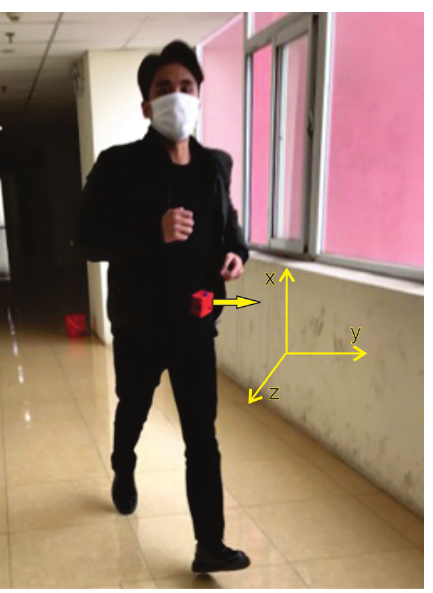
Fig 8. The wearable device (red) was attached to the waist and secured by an elasticated strap. The x-axis of the accelerometer was parallel to the earth’s